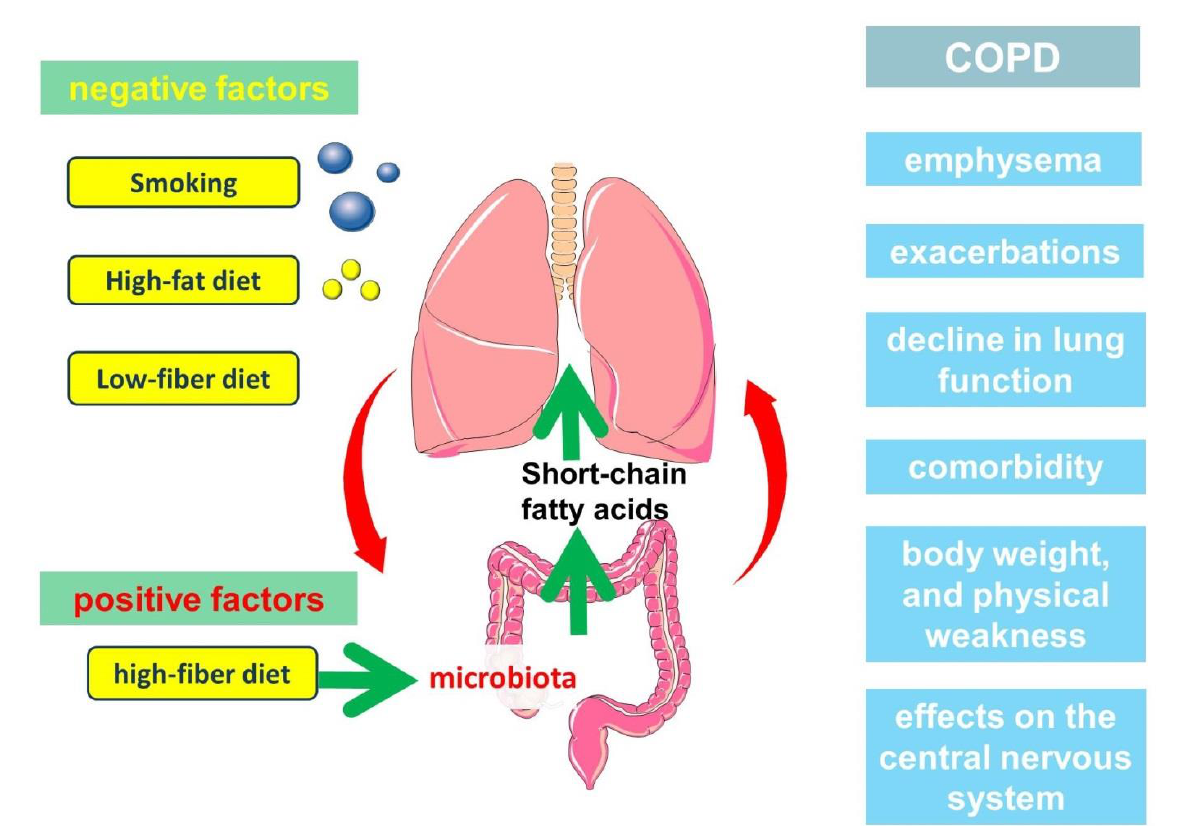
Figure 3. The participation of short-chain fatty acids in the pathogenesis of the clinically heteroge- neous course of COPD .